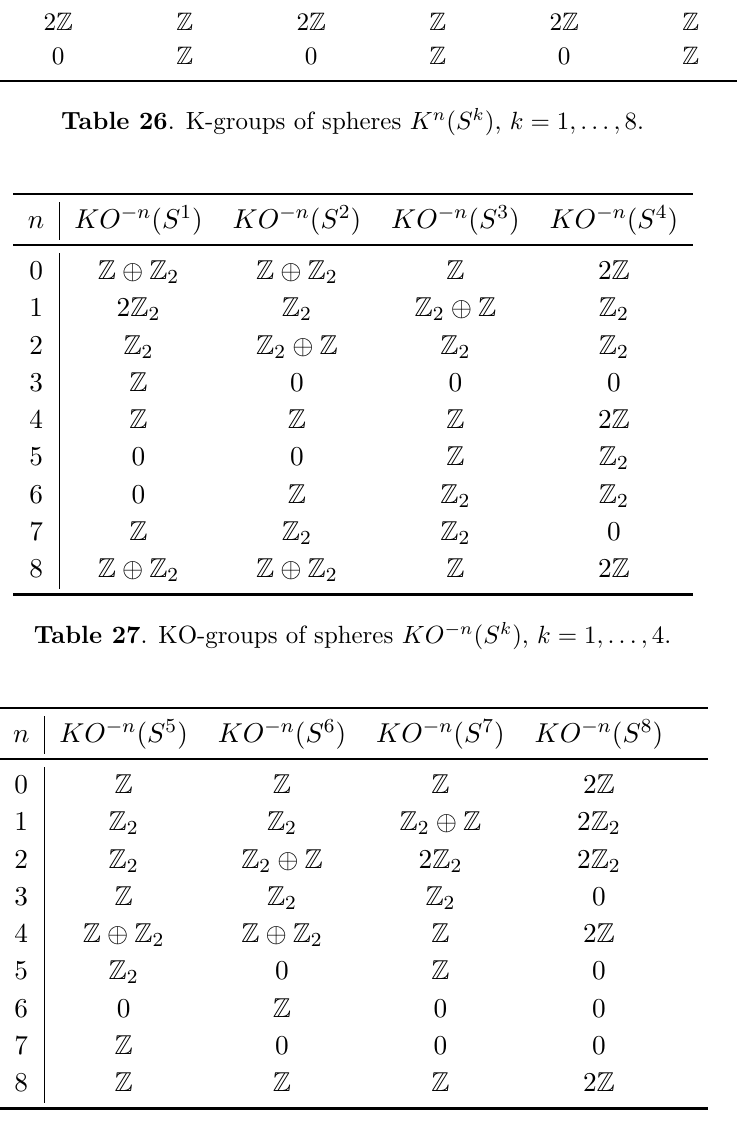
Table 28 . KO-groups of spheres KO − n ( S k ) , k = 6 , . . . , 8 . Note that Bott periodicity is respected